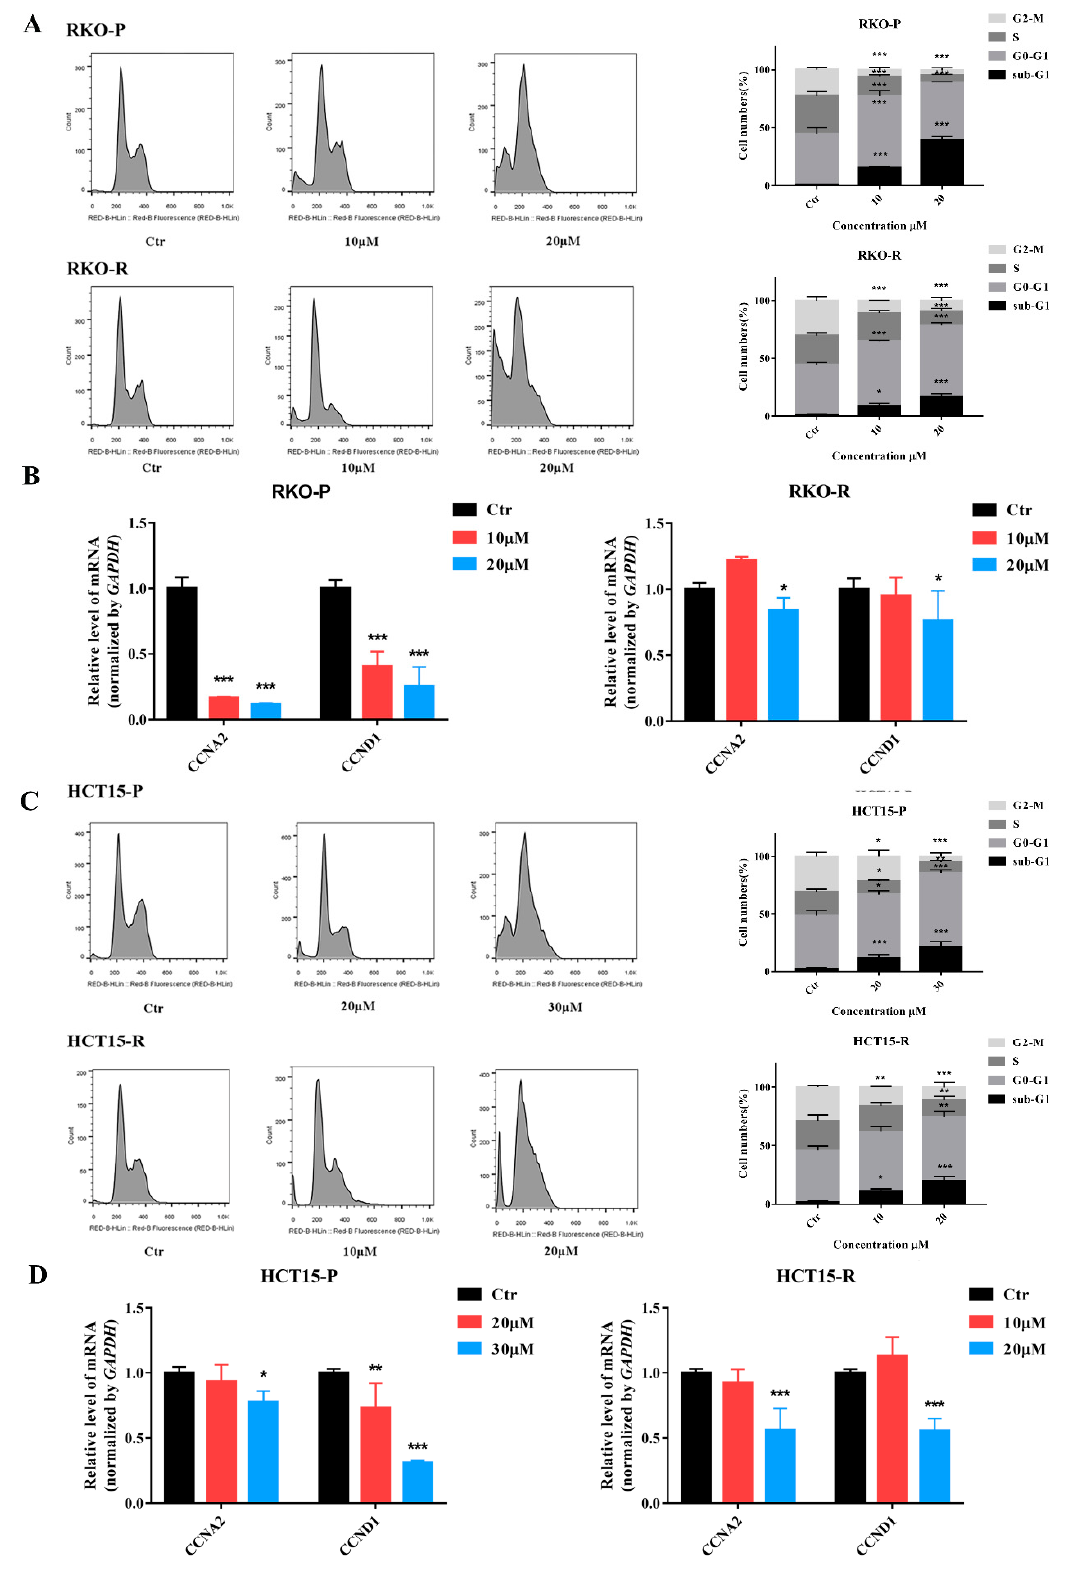
Figure 5. AGE arrested cell cycle at the G0-G1 phase in 5-FU-sensitive/resistant CRC cell lines. ( A , C ): The cell cycle was determined by flow cytometry after cells stained with PI/RNase. The results of the cell cycle are shown on the right. ( B , D ): Two cell cycle genes, CCNA2 and CCND1 , are measured by RT-PCR. The data was analyzed using a 2 − ∆∆ Ct approach. Results are expressed as mean ± SD ( n = 3). * p < 0.05, ** p < 0.01, *** p < 0.001, compared with Ctr group.